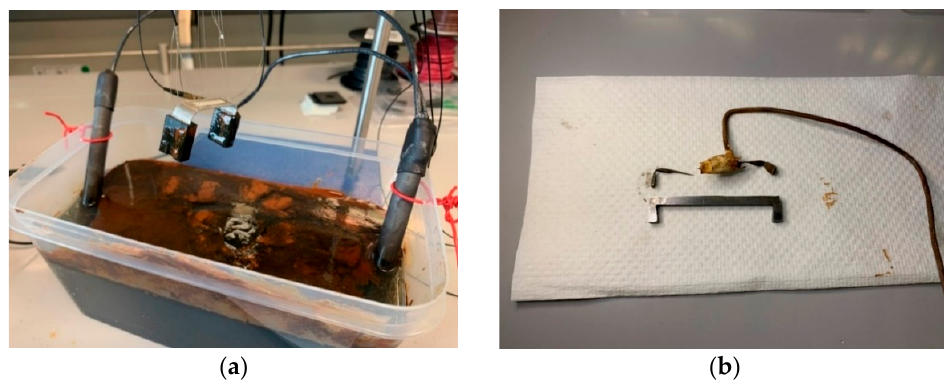
Figure 17. End of the experiment. ( a ) NaCl/water solution after corrosion. ( b ) Sacrificial Specimen before and after corrosion.